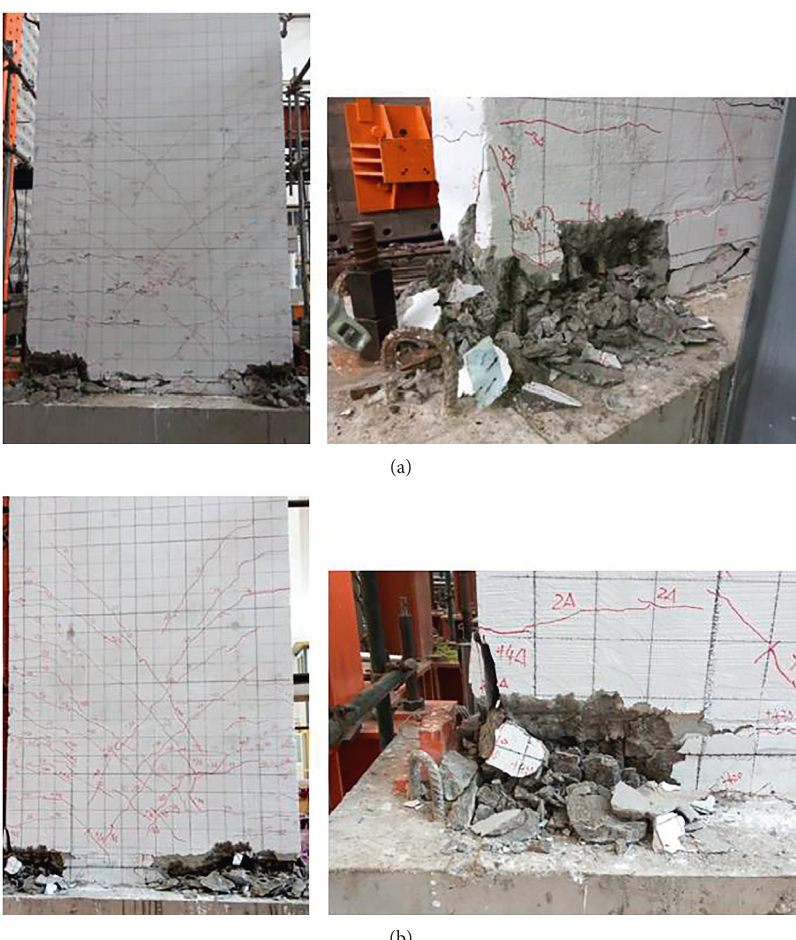
Figure 13: Final crack pattern and failure mode of (a) RHC-1 specimen and (b) RHC-2